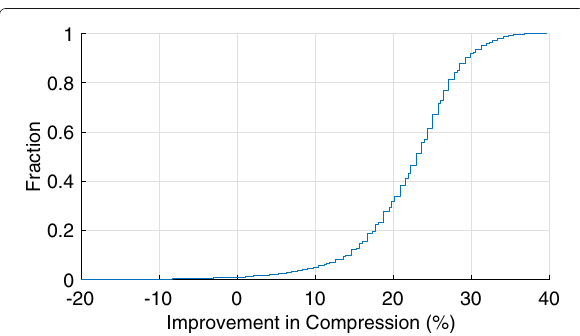
Fig. 13 Improvement with Huffman coding. The improvement in compression ratio when running Huffman coding after CSIApx is shown for the experimental